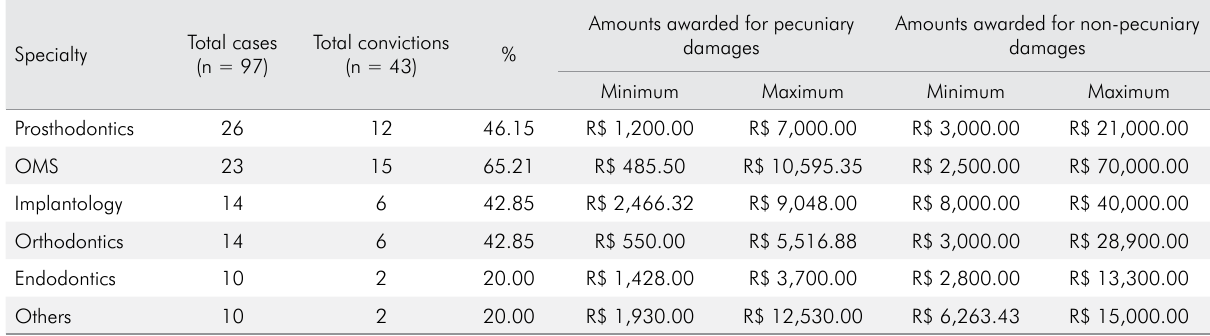
Table 1. Distribution of cases according to specialty, convictions and claim amounts (maximum and minimum values for pecuniary and non-pecuniary damages).